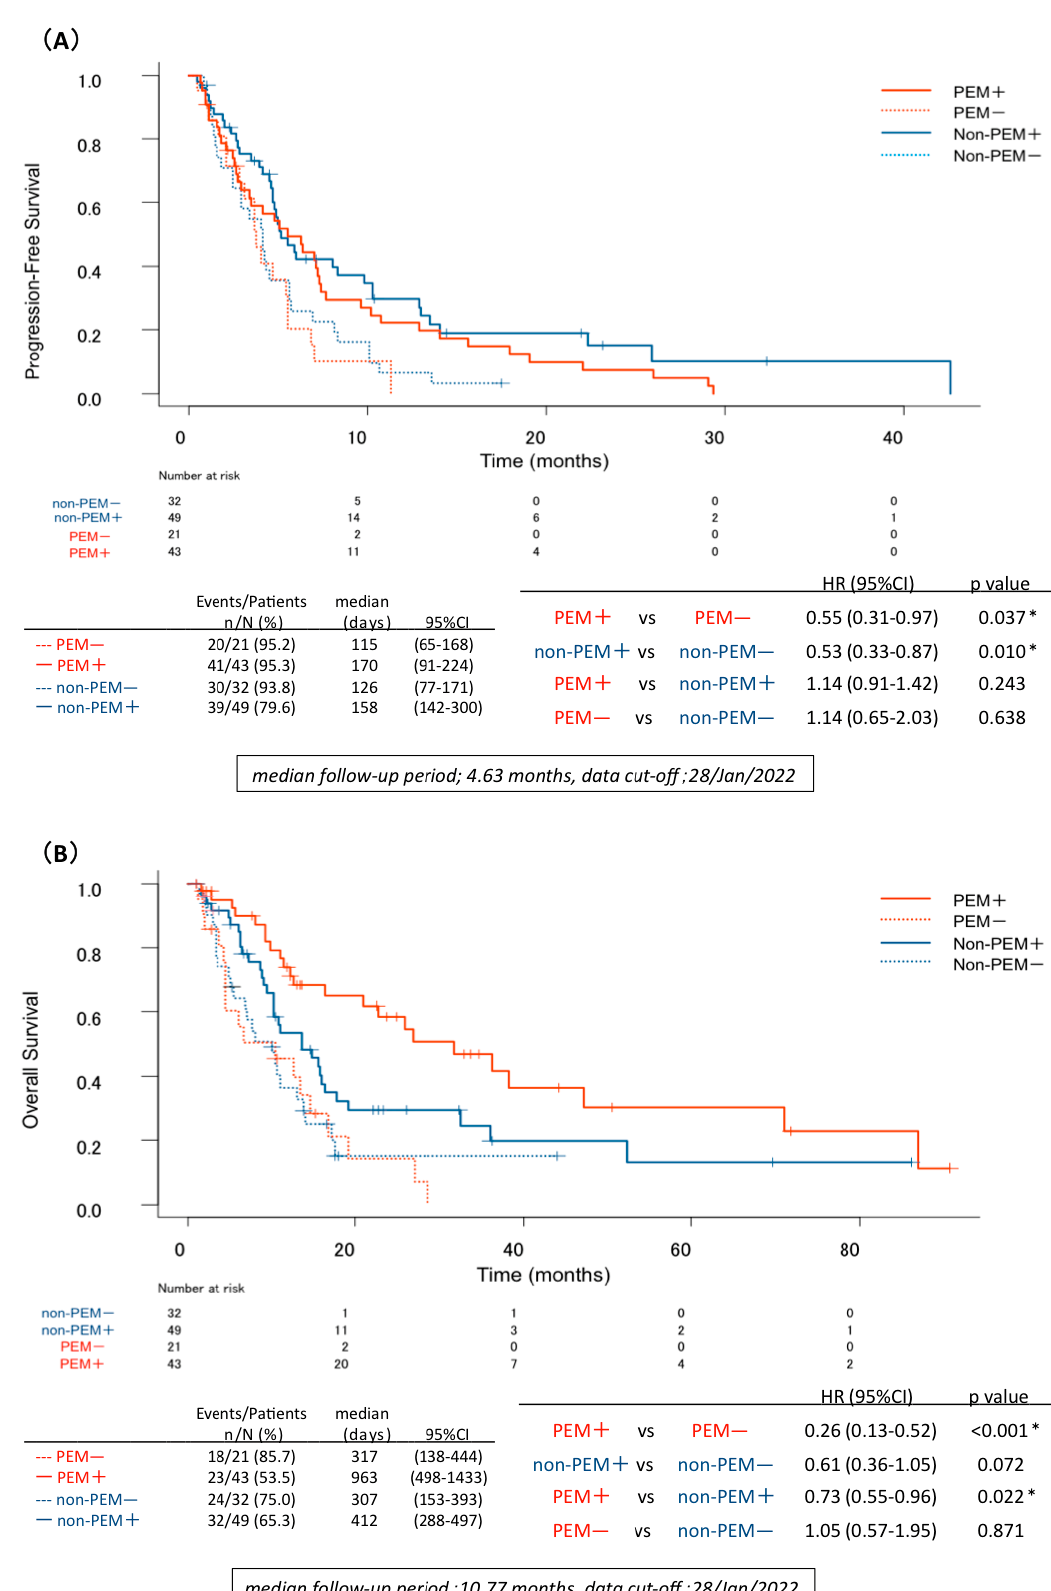
Figure 2. Kaplan–Meier curves of ( A ) PFS and ( B ) OS for each group. Abbreviations: PFS—progression-free survival; OS—overall survival; PEM—pemetrexed; *—statistically significant.